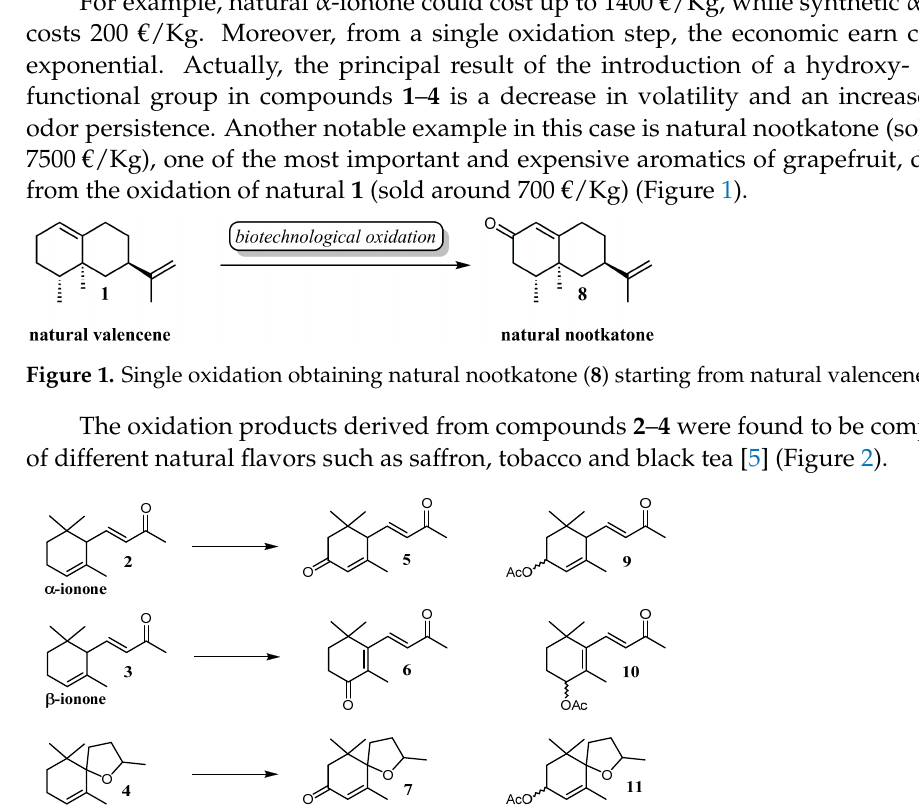
Figure 2. Oxidation products derived from α -ionone ( 2 ), β -ionone ( 3 ), and theaspirane ( 4 ) named 3-keto- α -ionone ( 5 ); 3- acetoxy- α -ionone ( 9 ); 4-keto- β -ionone ( 6 ); 4-Acetoxy- β -ionone ( 10 ); theaspirane ( 7 ) and 3-acetoxy-theaspirane ( 11 ), respectively.